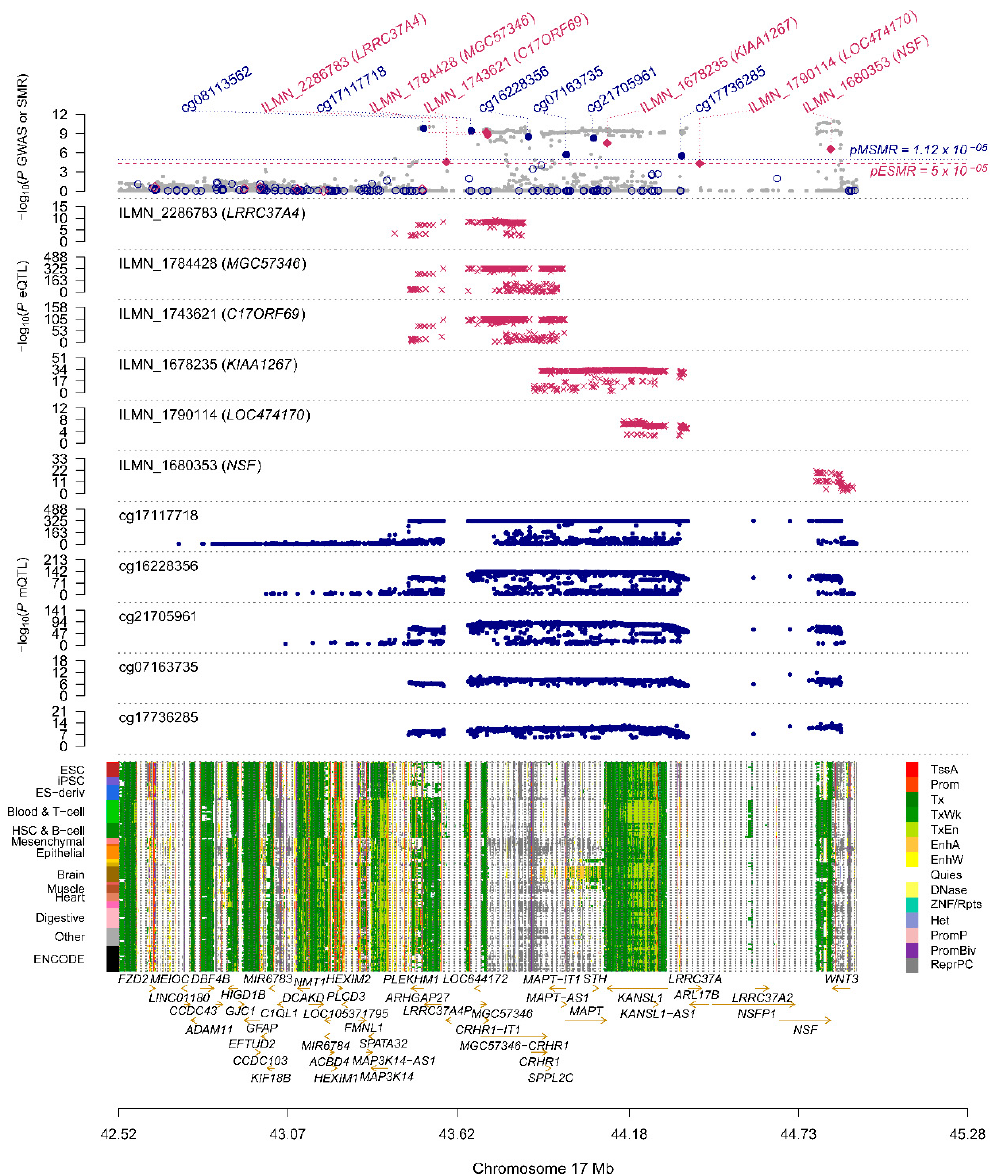
Figure 6. Summary of SMR correlation analysis across GWAS, eQTL and mQTL on Chr17. The figure above shows the − log10 ( p -values) of the SNPs from meta-analytic GWAS data. The middle two graphs are − log10 ( p -values) of SNPs in eQTL and mQTL, respectively. The lower diagram shows chromatin status annotation information.